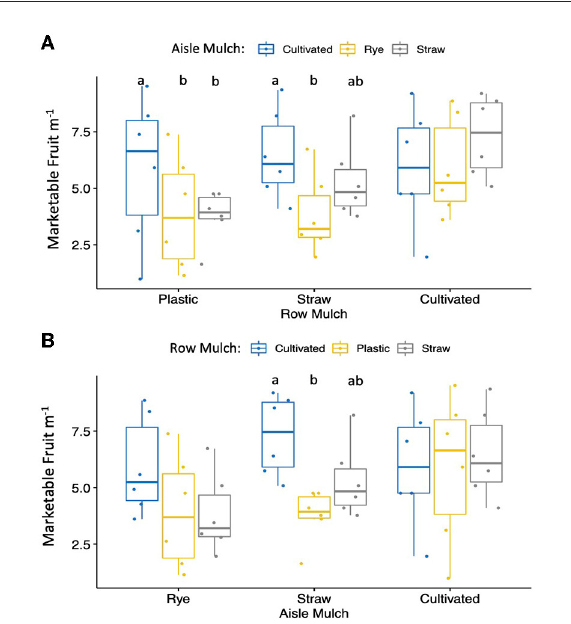
FIGURE3 Marketable fruit yield m − 1 of acorn squash grown using different row mulch (A) and aisle mulch (B) treatments. (A) Lowercase letters indicate significance groupings for aisle mulch within a given row mulch group, p < 0.05. (B) Lower letters indicate significance groupings for row mulch treatments within a given aisle mulch group, p <